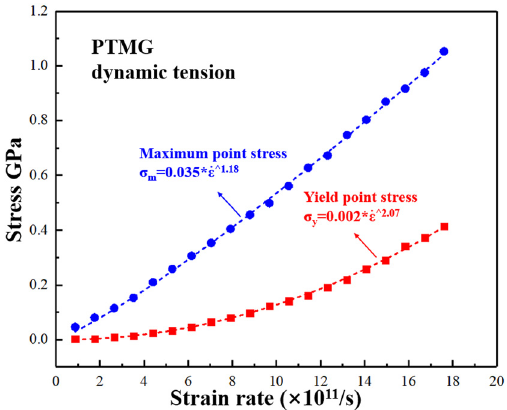
Figure 4: Quantitative analysis on the strain rate dependencies of the maximum stress and yield